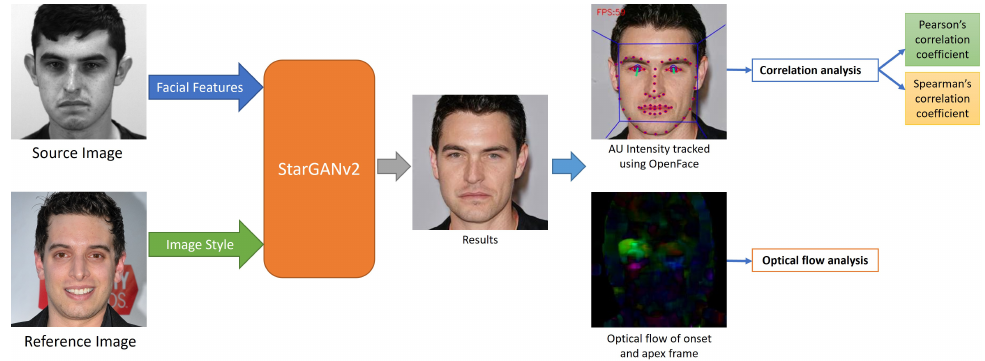
Figure 1. Overall pipeline of our method with analysis. StarGANv2 is used to modify the “style“ of participant from SAMM-LV dataset [8]. The synthetic image exhibit the style extracted from the reference image (from FFHQ dataset [28]) while maintaining the facial features of the source image. Facial Action Units (AUs) of the synthetic image is measured using OpenFace [29]. The AUs and optical flow of the synthetic image are compared with the original source